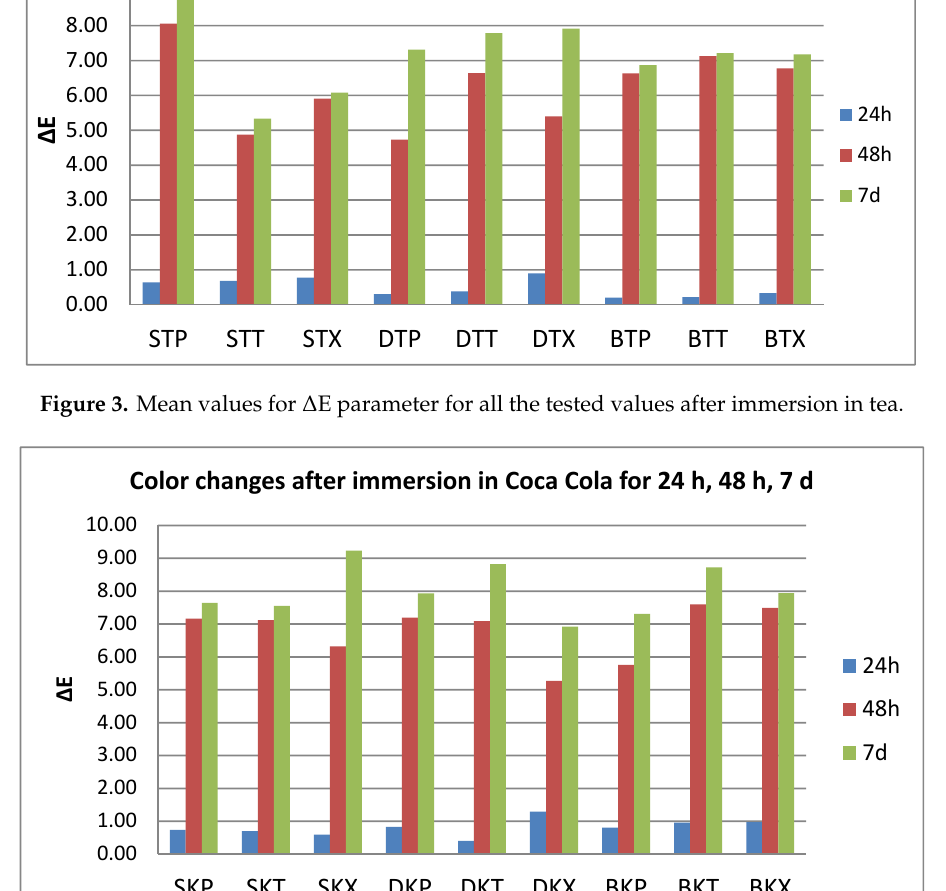
Figure 4. Mean values for ∆ E parameter for all the tested values after immersion in Coca-Cola. Polymers 2020 , 12 , x FOR PEER REVIEW